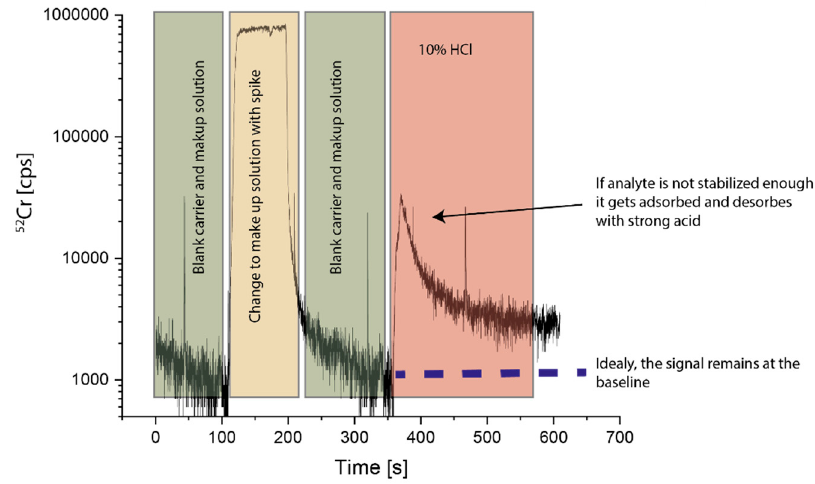
Figure 1. Demonstration of the optimization process for the make-up and carrier solutions: If the analyte was not stabilized enough, it was absorbed onto the walls, and it appeared as a peak if it was desorbed by concentrated acid.